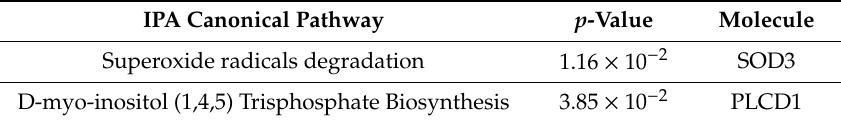
Figure 2. Functional categorization by Gene Ontology (GO) analysis of the proteins differentially expressed between BAV and TAV patients. The top 10 GO terms in each of the three main categories of GO classification (molecular function, cellular component and biological process) are displayed. The y axis represents the percentage of a specific category of proteins within the main category. Table 2. Significant canonical pathways with enriched protein expression.